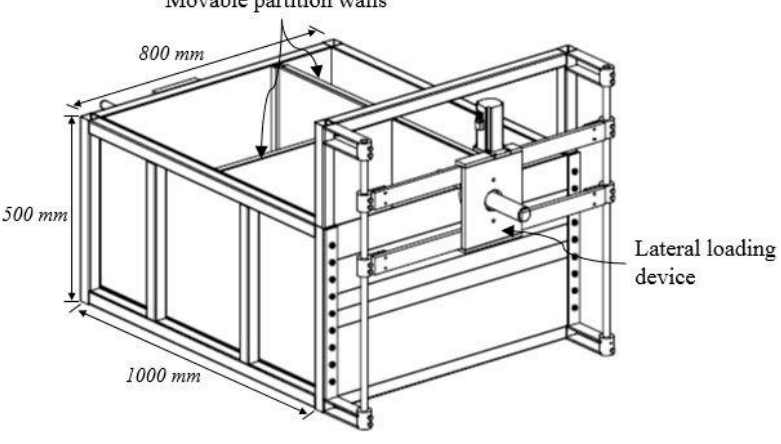
Figure 2. Schematic diagram of the laboratory soil chamber used in this study.